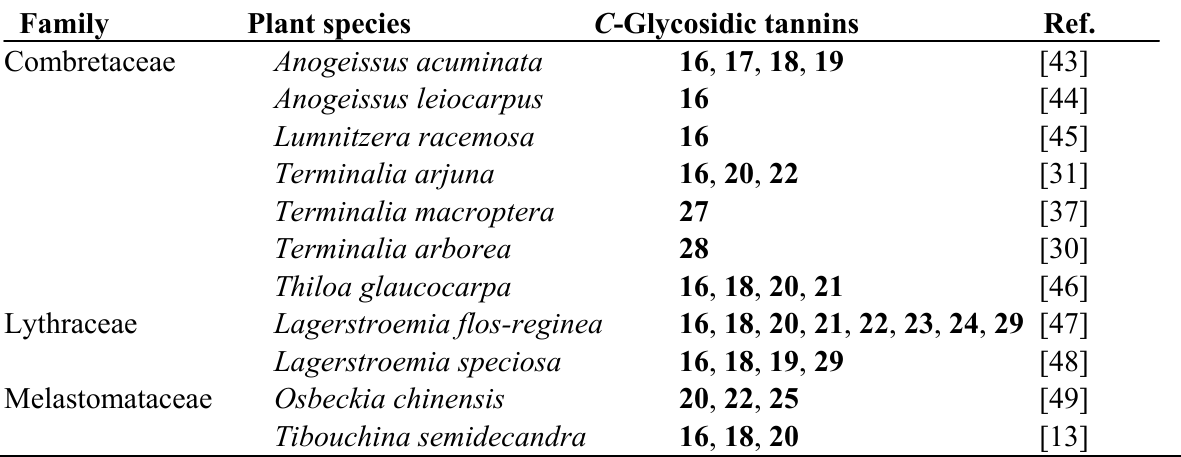
Table 2. C -Glycosidic ellagitannins in the order